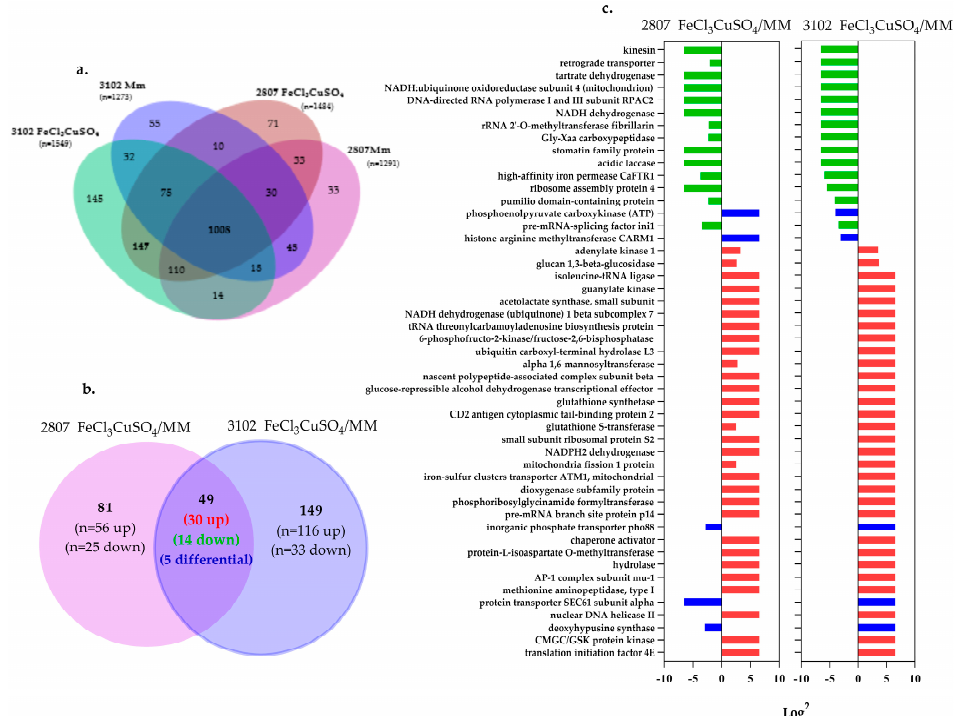
Figure 5. Label-free quantitative proteomics results. ( a ) Venn diagram of total identified proteins in each isolate and condition. ( b ) Venn diagram of the differentially abundant proteins (49 common proteins). ( c ) Proteins that increased and decreased their abundance after metal exposure in both clinical isolates of C. neoformans var grubii. In red, proteins up-regulated; in green, proteins down- regulated; and in blue, those that presented an opposite abundance between the two isolates.